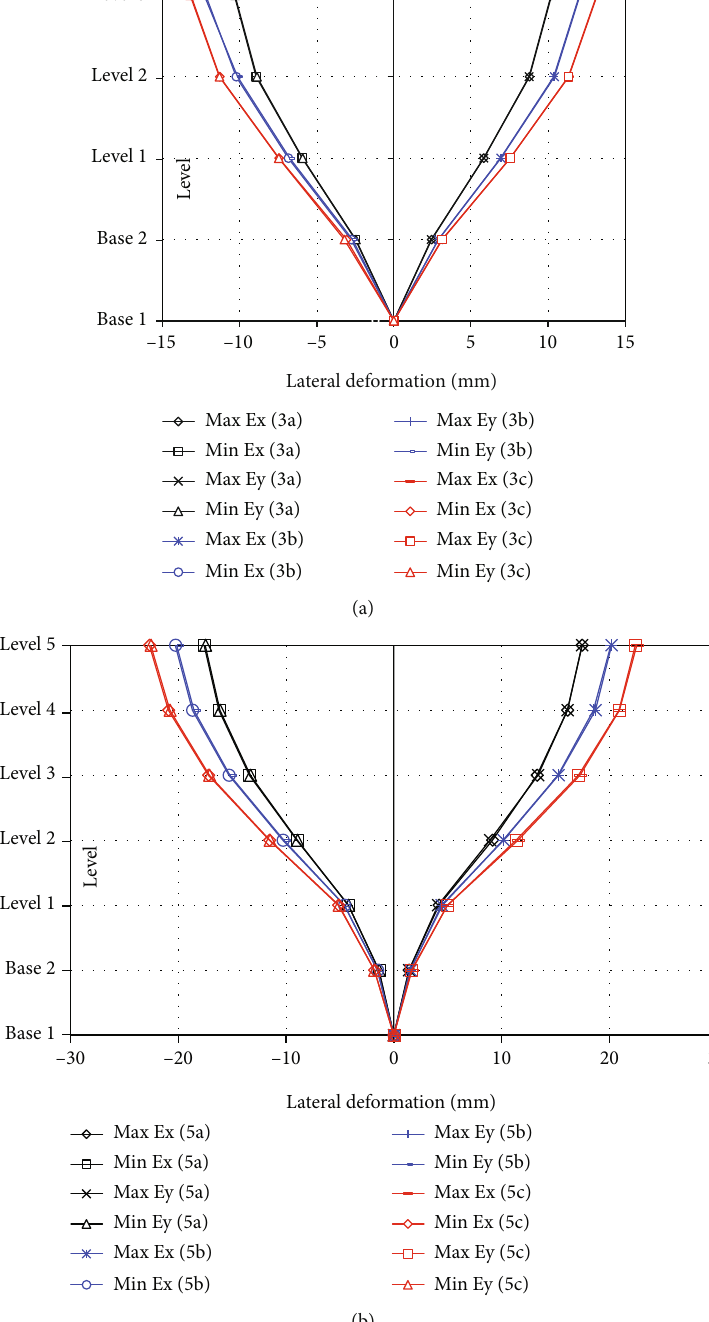
Figure 5: Lateral deformation due to the E